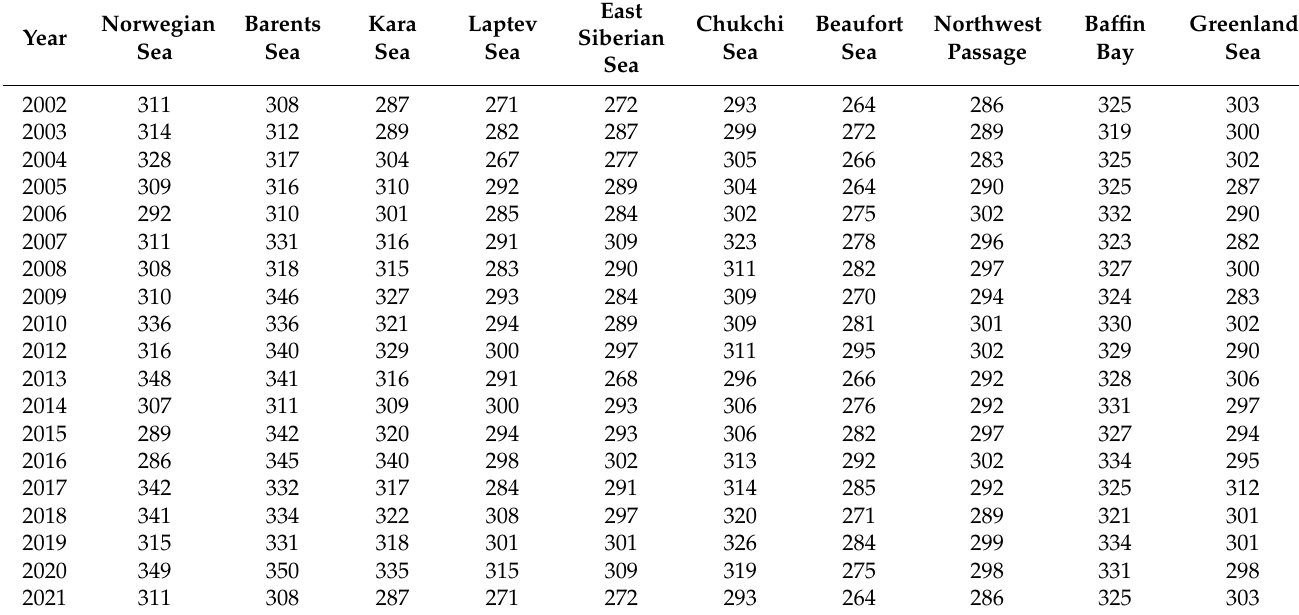
Table 7. The DoY of Arctic sea ice complete freeze from 2002 to